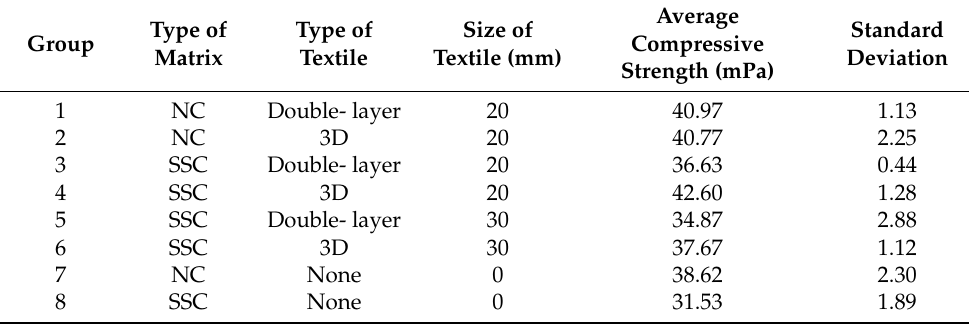
Table 5. Average compressive strength of each group of